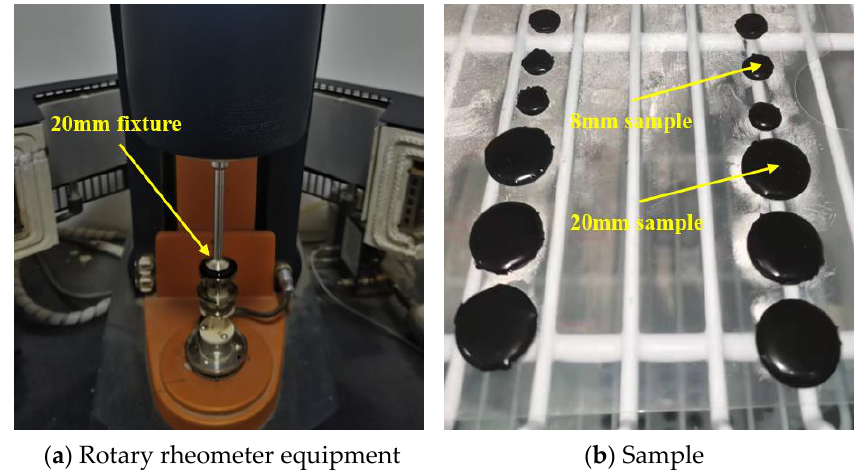
Figure 2. Test instrument and sample of DSR.